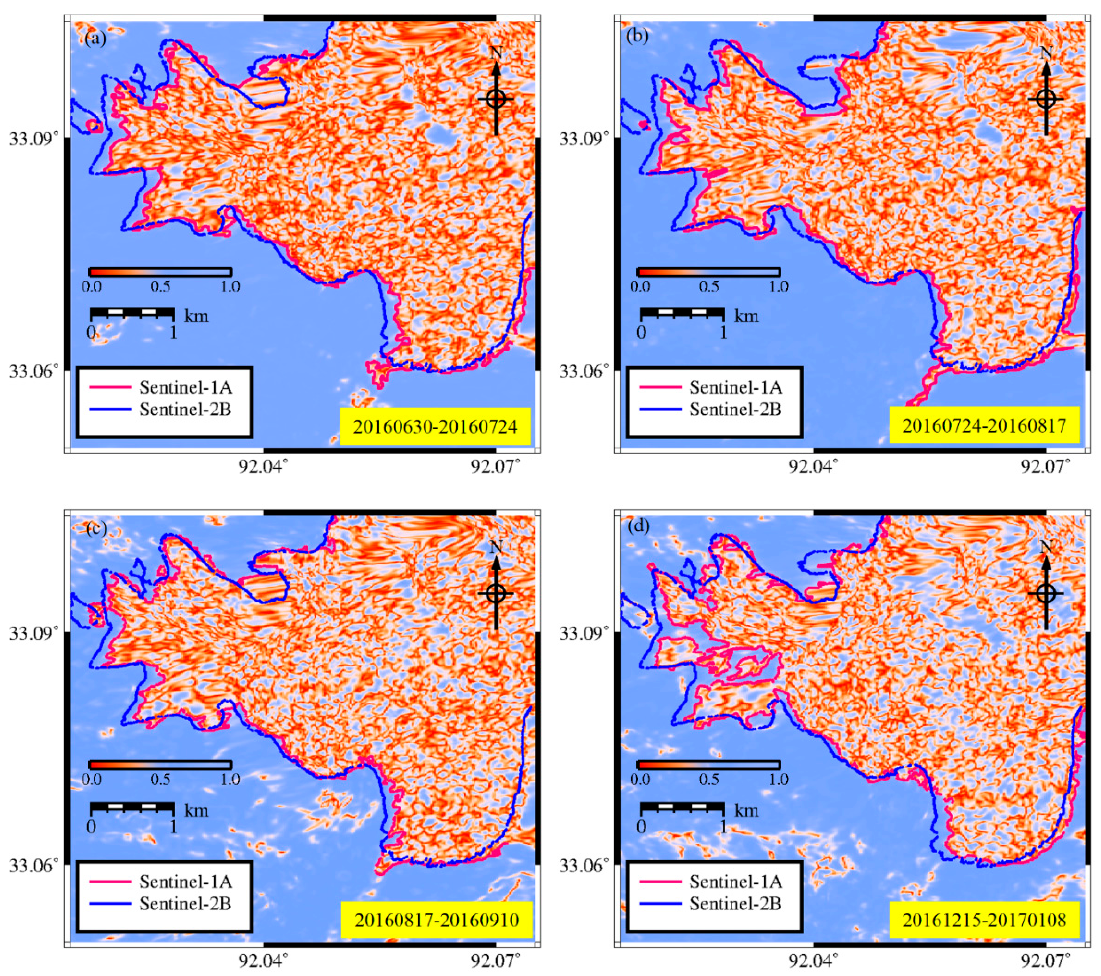
Figure 11. ( a – d ) show the four maps of the DDG boundaries (solid red curves) extracted using the Sentinel-1A coherence maps spanning between June and September (i.e., in the glacier ablation period) and around December in 2016. The DDG boundaries (solid blue curves) derived from the Sentinel-2B optical image are superimposed for a visual check.